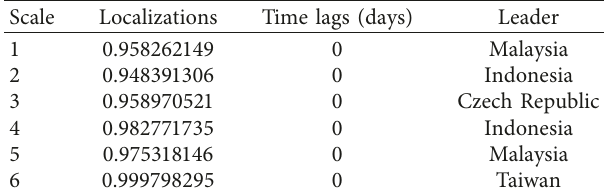
Table 6: Wavelet multiple cross correlations (WMCC). Scale Localizations Time lags (days) Leading/lagging variable